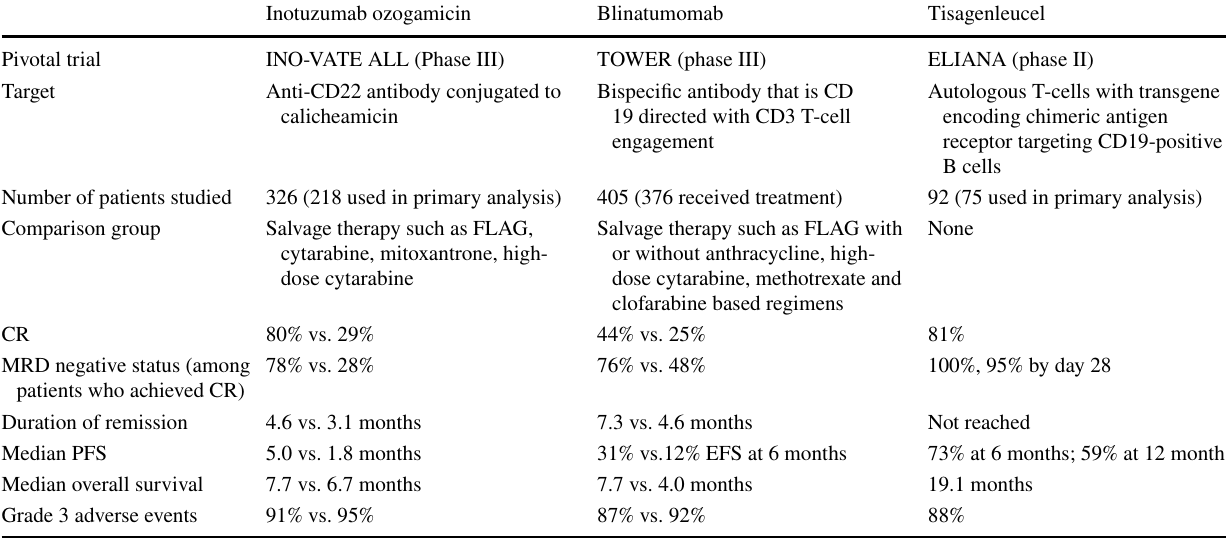
Table 1 Pivotal studies for inotuzumab ozogamicin, blinatumomab, tisagenleucel (without matching-adjusted indirect comparison analysis) [5, 21, 29, 30, 35,